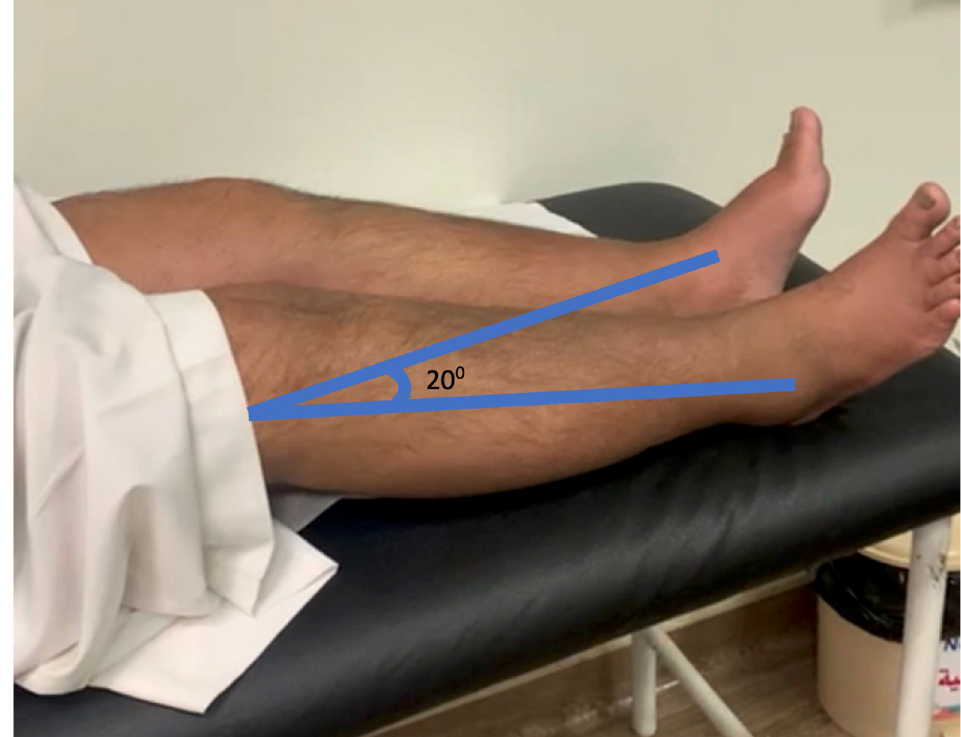
Figure 3. The patient showing disruptive extensor mechanism by right positive leg-raising test. The patient is trying to lift the right leg; the thigh portion is lifting from the bed surface, but the heel is not lifting due to a complete rupture in the quadriceps muscle.